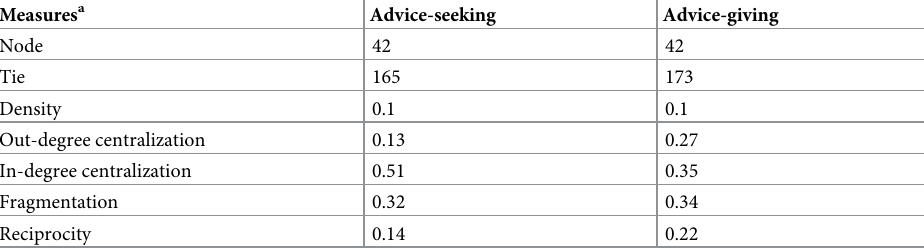
Table 3. Global measures of the advice-seeking and advice-giving